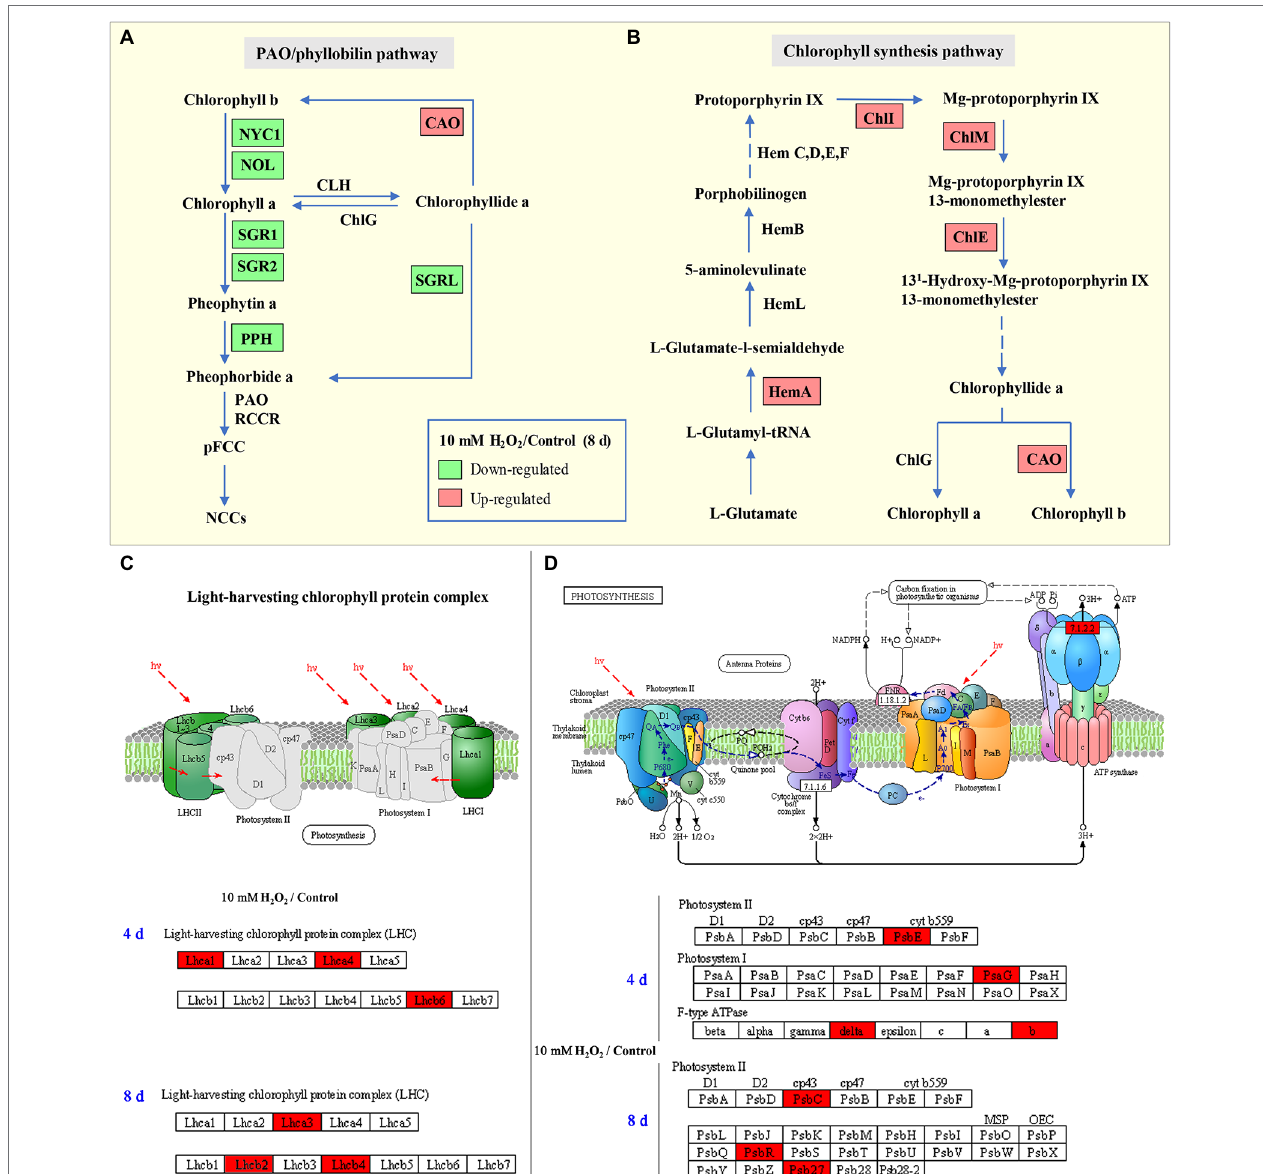
FIGURE 7 | Schematic map of chlorophyll degradation (A) and biosynthesis (B) pathways, light-harvesting complex (C) , and photosynthesis (D) in Chinese flowering cabbage leaves. Red color indicates upregulation and green color indicates downregulation of proteins/genes in the H 2 O 2 treatment group relative to the control group. Lhc: light-harvesting complex; HemA: Glutamyl-tRNA reductase; ChlI: magnesium ion chelating enzyme; ChlM: magnesium-protoporphyrin O-methyltransferase; ChlE: magnesium-protoporphyrin IX monomethyl ester cyclase; ChlG: chlorophyll/bacteriochlorophyll a synthase; CAO: chlorophyllide a oxygenase; NYC1: non-yellow coloring 1; NOL: NYC1-like; SGR: stay-green; SGRL: SGR-like; and PPH: pheophytin pheophorbide